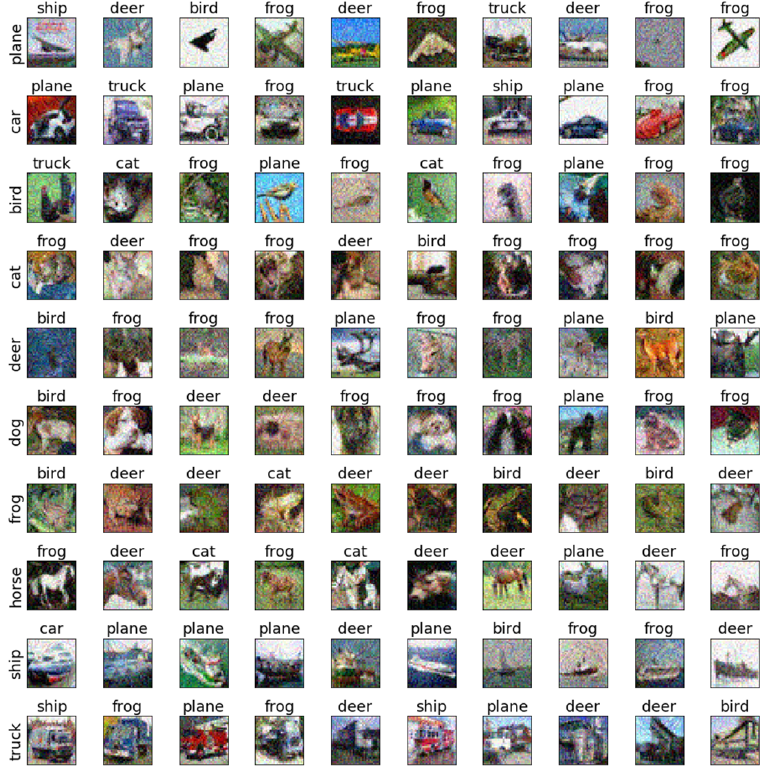
Figure 16. The adversarial examples of PGD for Cifar10 and ResNet18.